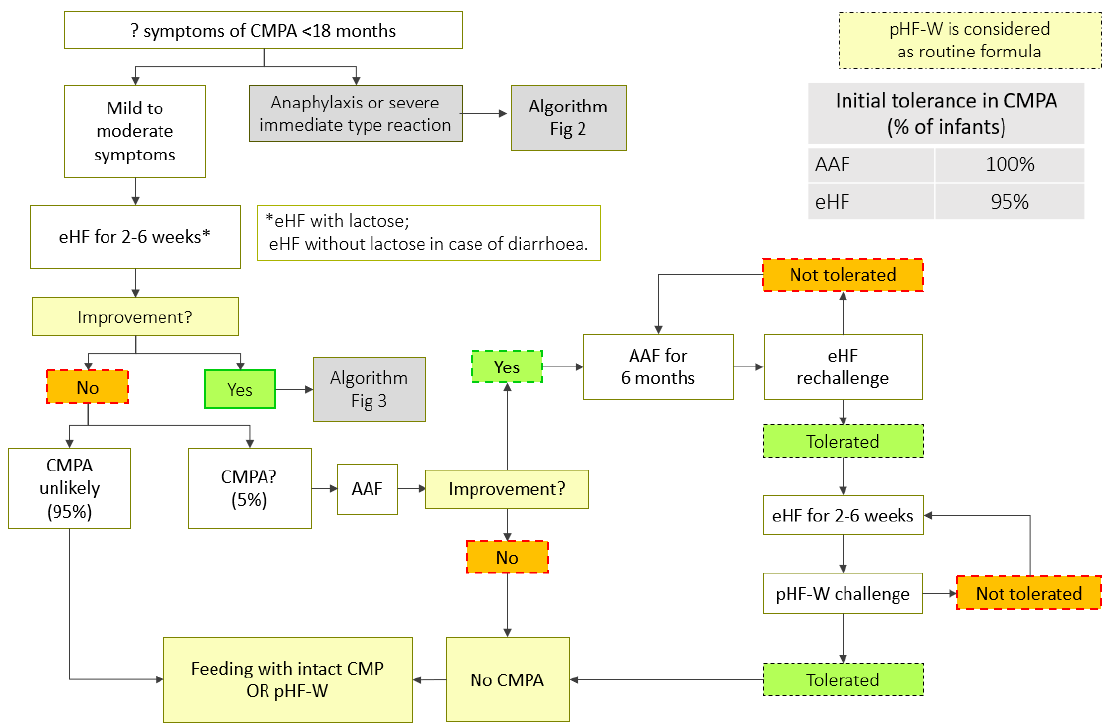
Figure 4. CMPA step-down treatment algorithm (mild-to-moderate symptoms). AAF: amino acid Figure 4